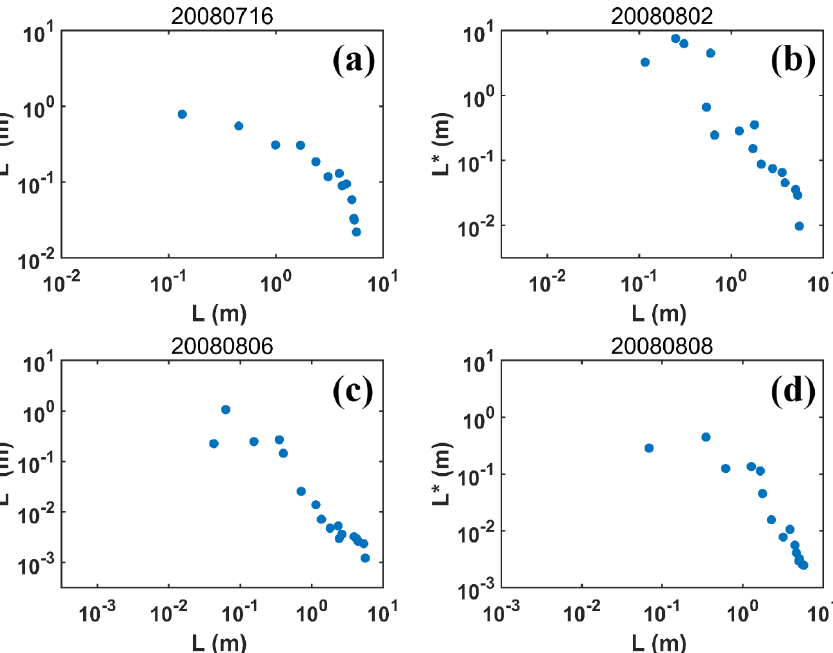
Figure 9. Relationships of transitional scale ( L ∗ ) vs. droplet-free air length ( L) on (a) 16 July 2008, (b) 2 August 2008, (c) 6 August 2008 and (d) 8 August